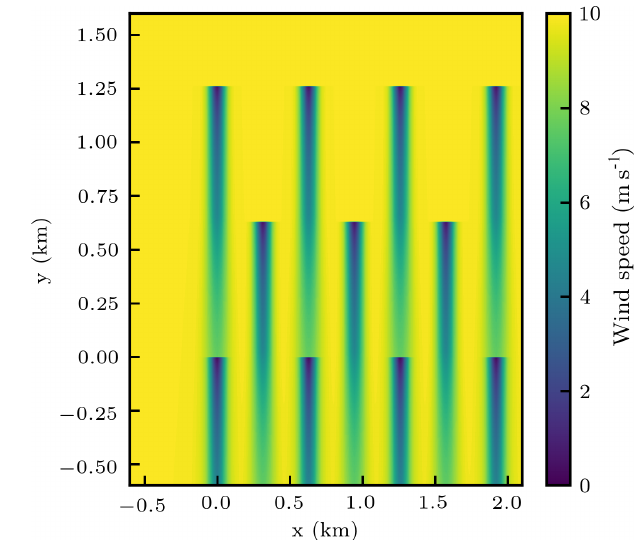
Figure 4. Contours of wind speed for the 11-turbine wind farm with the baseline yaw configuration ( y = 0 ) and 10ms − 1 inflow speed. Brighter colors correspond to faster wind speeds.